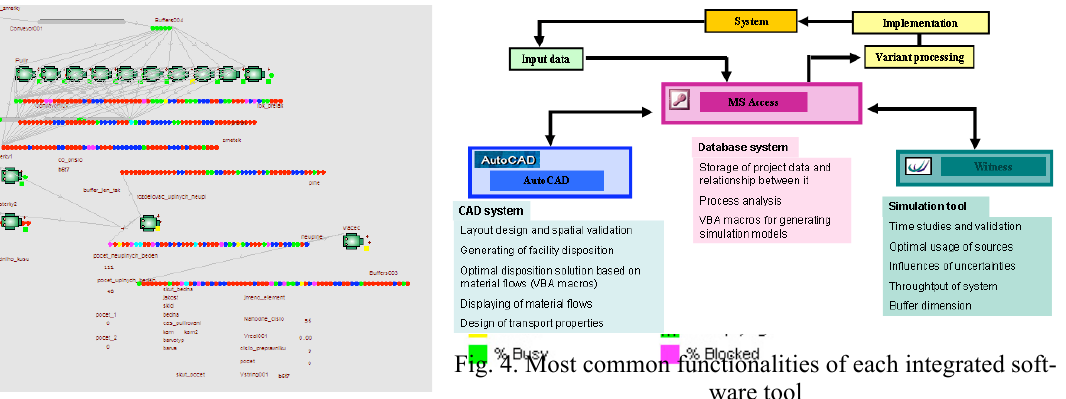
Fig. 3. Screenshot of simulation model and example of simu-